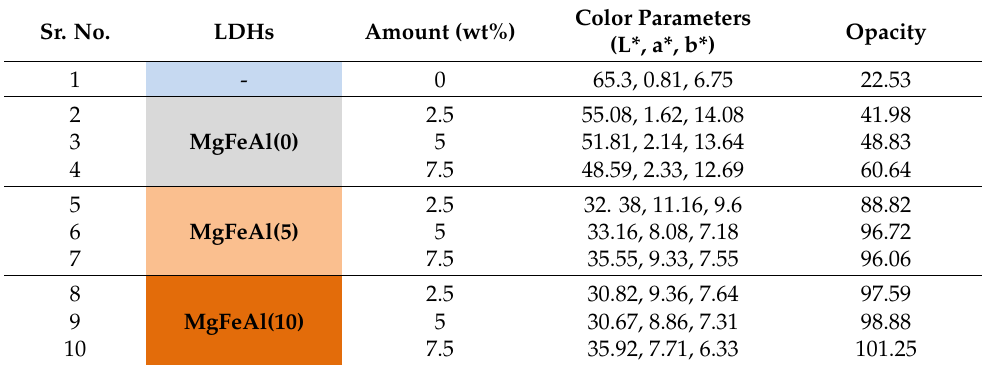
Table 2. Color parameters (L*, a*, b*) and opacity measured by spectrophotometer. Sr.